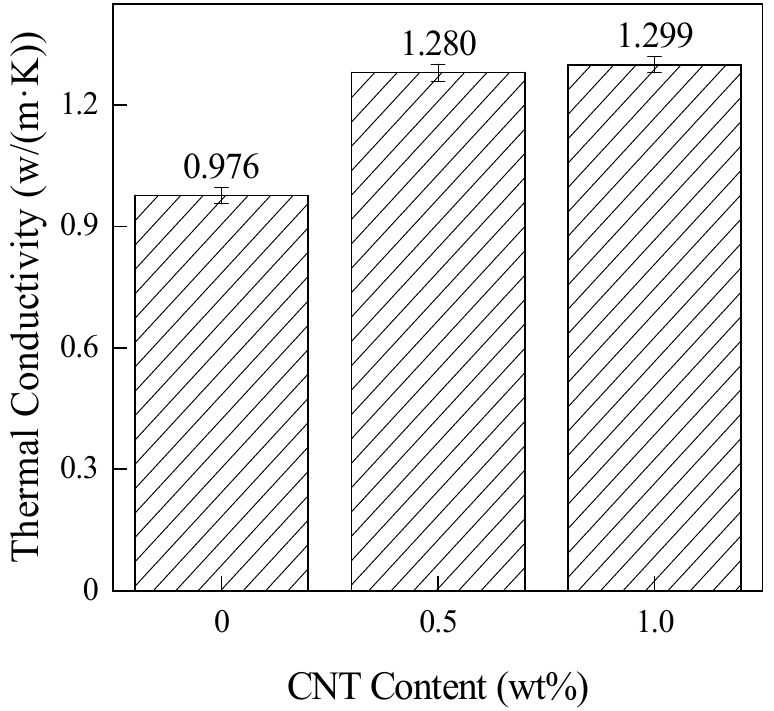
Figure 5. In-surface thermal conductivity of the composites with different CNT contents.